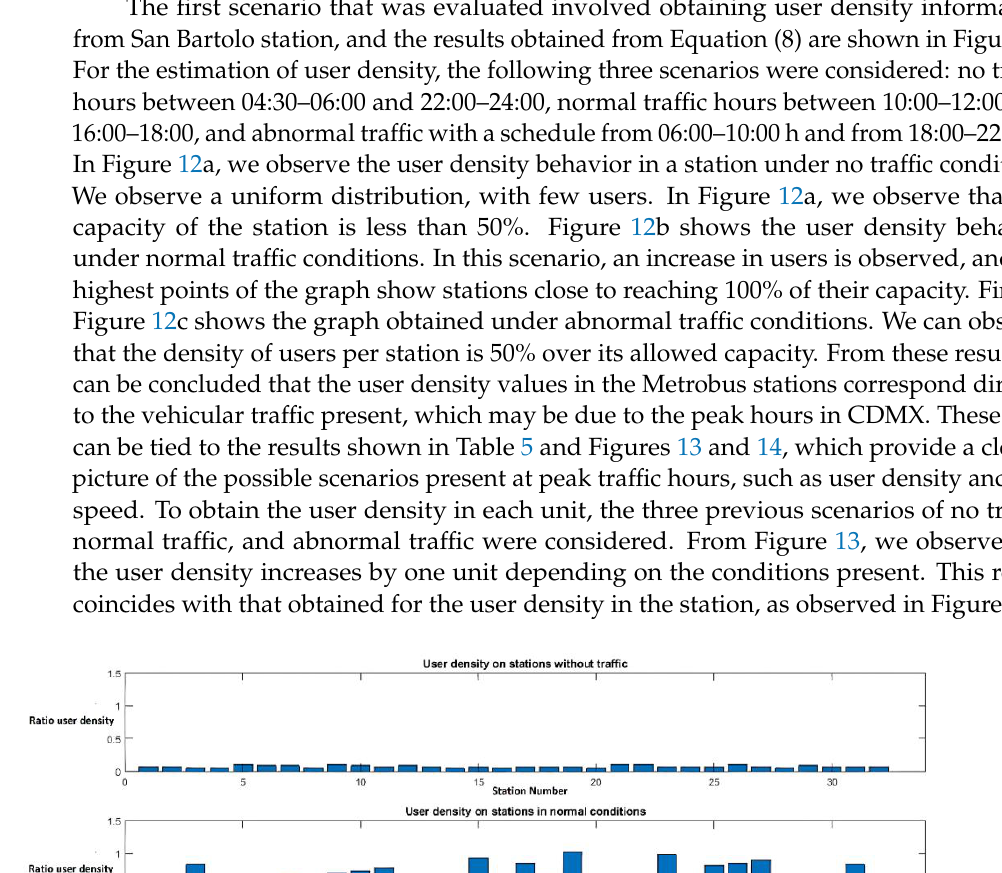
Figure 13. Density of users in a unit: ( a ) units without traffic conditions and ( b ) units under normal traffic conditions. See Table 3. From Equation (9), we obtain Figure 13. Figure 13a shows the density of users in a unit under without traffic conditions, which is at 30% of its capacity on average. Under normal traffic conditions, it reaches 65% of the average capacity (Figure 13b). The data obtained reflect the behavior observed throughout the operation of the service in CDMX. The demand is given according to the traffic conditions of the day. Continuing with the MAP model analysis, the user density model was evaluated by the period of the day. As Figure 14 demonstrates, the data reflect the behavior analyzed on the routes. The results allow the periods of the day and the traffic conditions where there is a greater density of users, that is, a greater demand for service, to be identified. Within the hours of 06:00 – 10:00, 12:00 – 16:00, and 18:00 – 22:00, the highest user density on the route was identified,